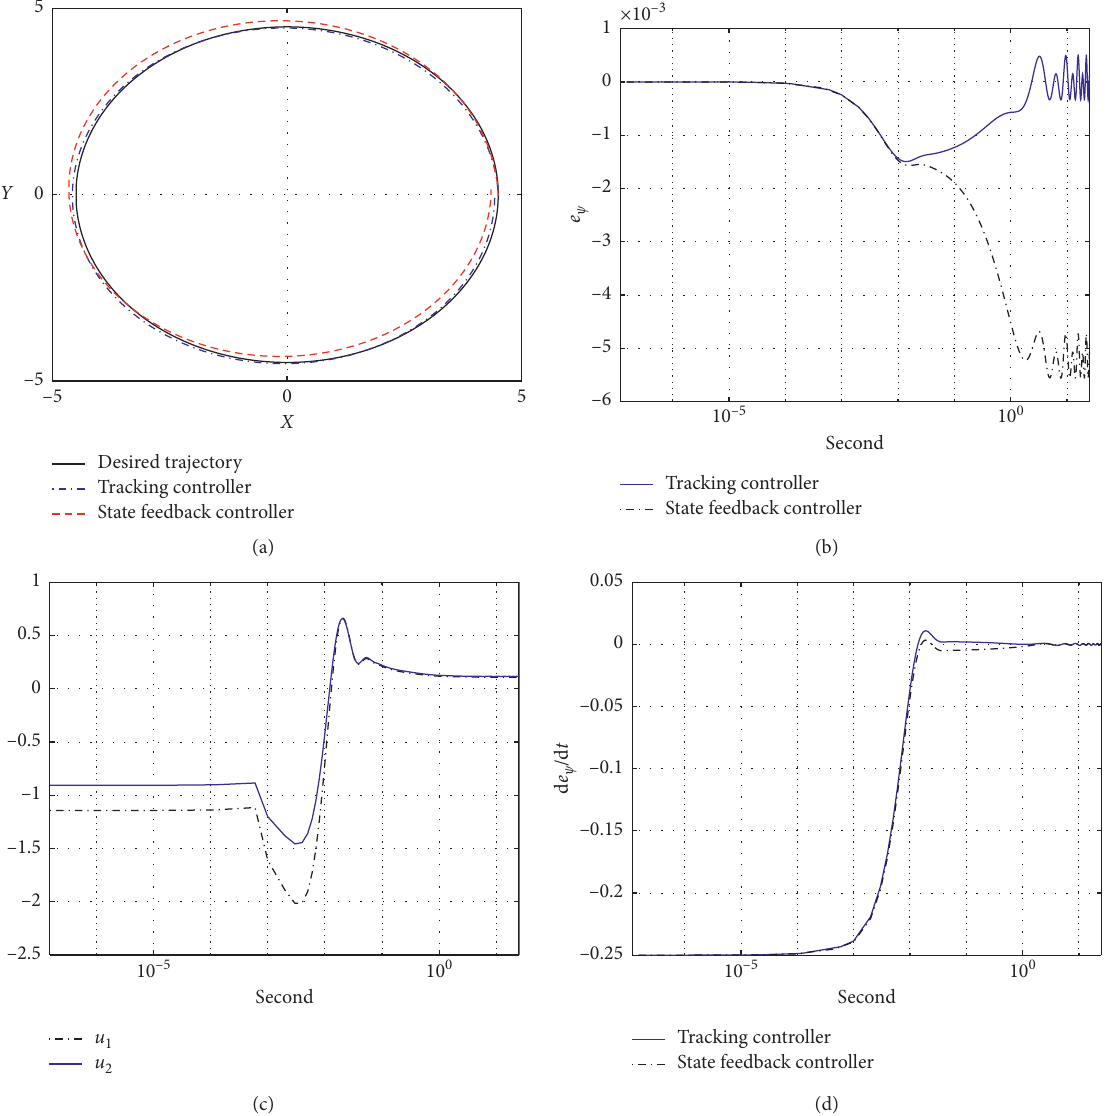
Figure 6: Comparisons on trajectory, control signals, ψ , and _ ψ . (a) Trajectories. (b) Error of yaw angle. (c) Control signals of the tracking controller. (d) Error of yaw angular